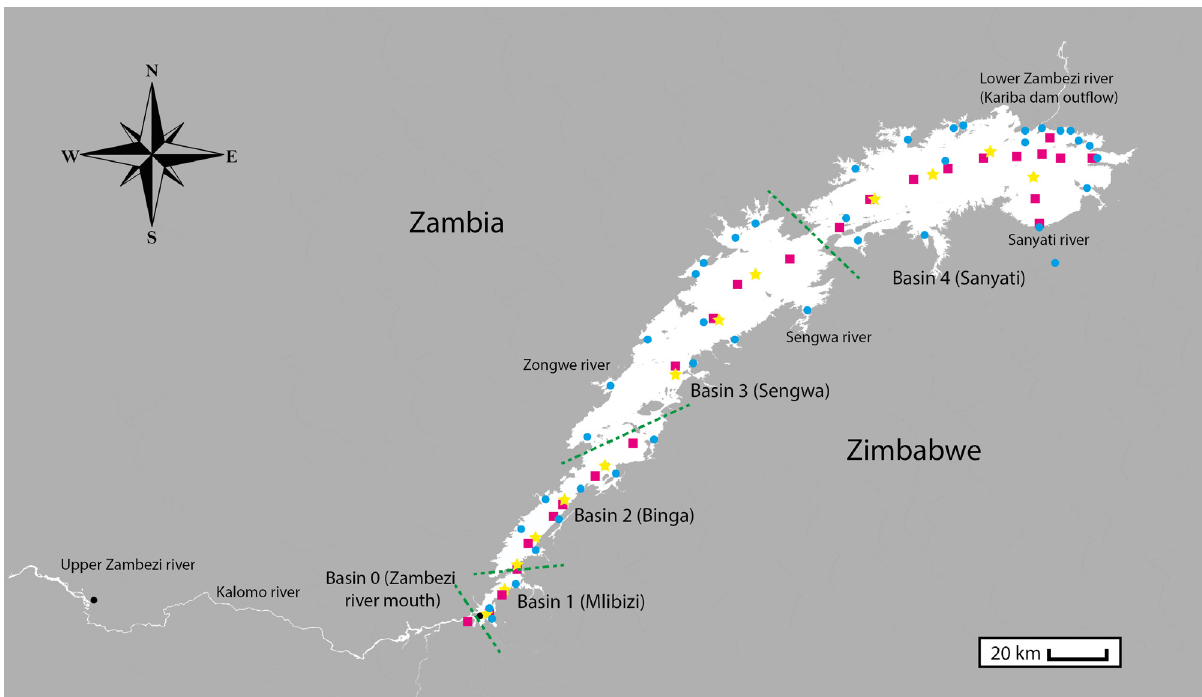
Fig. 1. Lake Kariba, its basins and most important rivers. Symbols indicate [total-P] sampling locations from the different studies. Sampling periods and studies are indicated by coloured symbols; magenta: 1964−1965, Coche (1968); yellow: 1987− 1993, Magadza (2010); blue: 2008−2018, Zambezi River Authority (unpubl. data). Map tiles by Stamen Design, under CC BY 3.0. Data by OpenStreetMap, under CC BY SA Table 2. To determine the carrying capacity of Lake Table 1. Morphometry of Lake Kariba and its basins at nor- mal operating water level (485 m), adapted from Balon